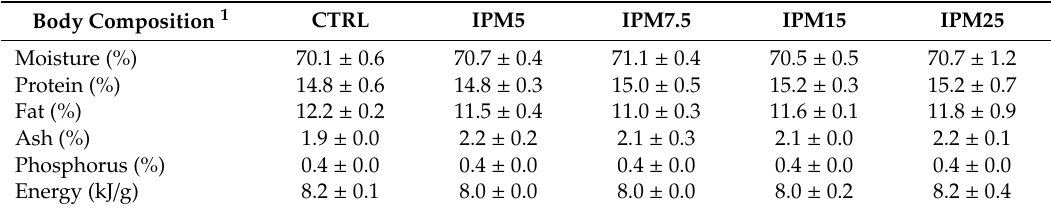
Table 3. Whole-body composition of rainbow trout fed the five experimental diets (Control: CTRL, and experimental diets with 5%, 7.5%, 15%, or 25% insect protein meal (IPM), respectively IPM5, IPM7.5, IPM15, and IPM25). Values are means ± standard deviations ( n = 3). Body Composition